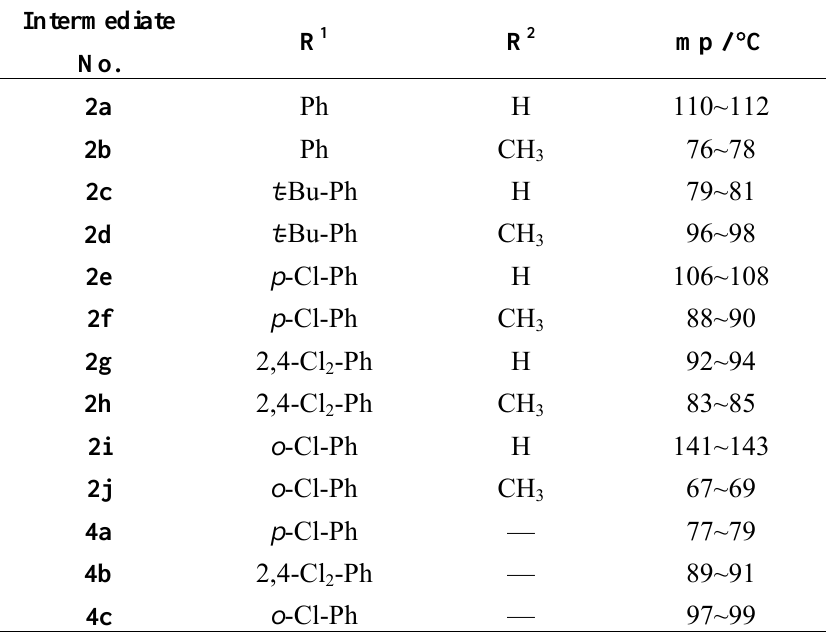
Table 2. The melting points and yields of intermediates 2 and 4